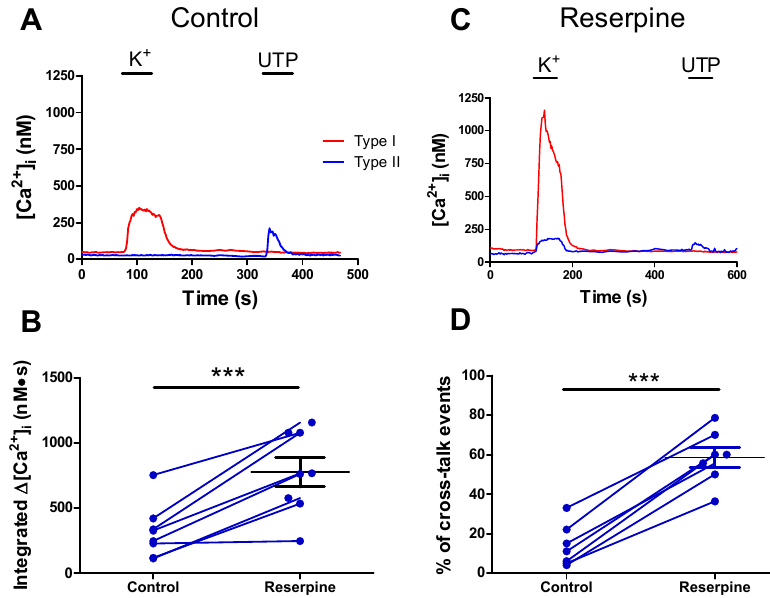
Figure 4. Depleting vesicular type I cell dopamine stores using reserpine enhances crosstalk from type I to type II cells. Representative traces showing intracellular Ca 2 + responses of type I and type II cells from a control ( A ) and ( C ) reserpine-treated ( C ) ‘sister’ culture as a result of exposure to high K + and UTP. ( B ) Integrated [Ca 2 + ] i in type II cells in response to high K + depolarization of neighboring type I cells in control versus reserpine-treated sister cultures. Blue lines connect mean values from type II cells imaged on the same day from paired ‘sister’ cultures. ( D ) Percent (%) of type II cells displaying crosstalk events during from high K + depolarization of type I cells in sister cultures. In B, * denotes significant di ff erence between control and reserpine-treated cells, evaluated using Student’s t-test (* = p < 0.05). In D, a one-way ANOVA followed by Tukey’s post hoc test was used; *** p < 0.001. Values are means ± S.E.M.; n = 8 dishes, 3–20 cells tested per